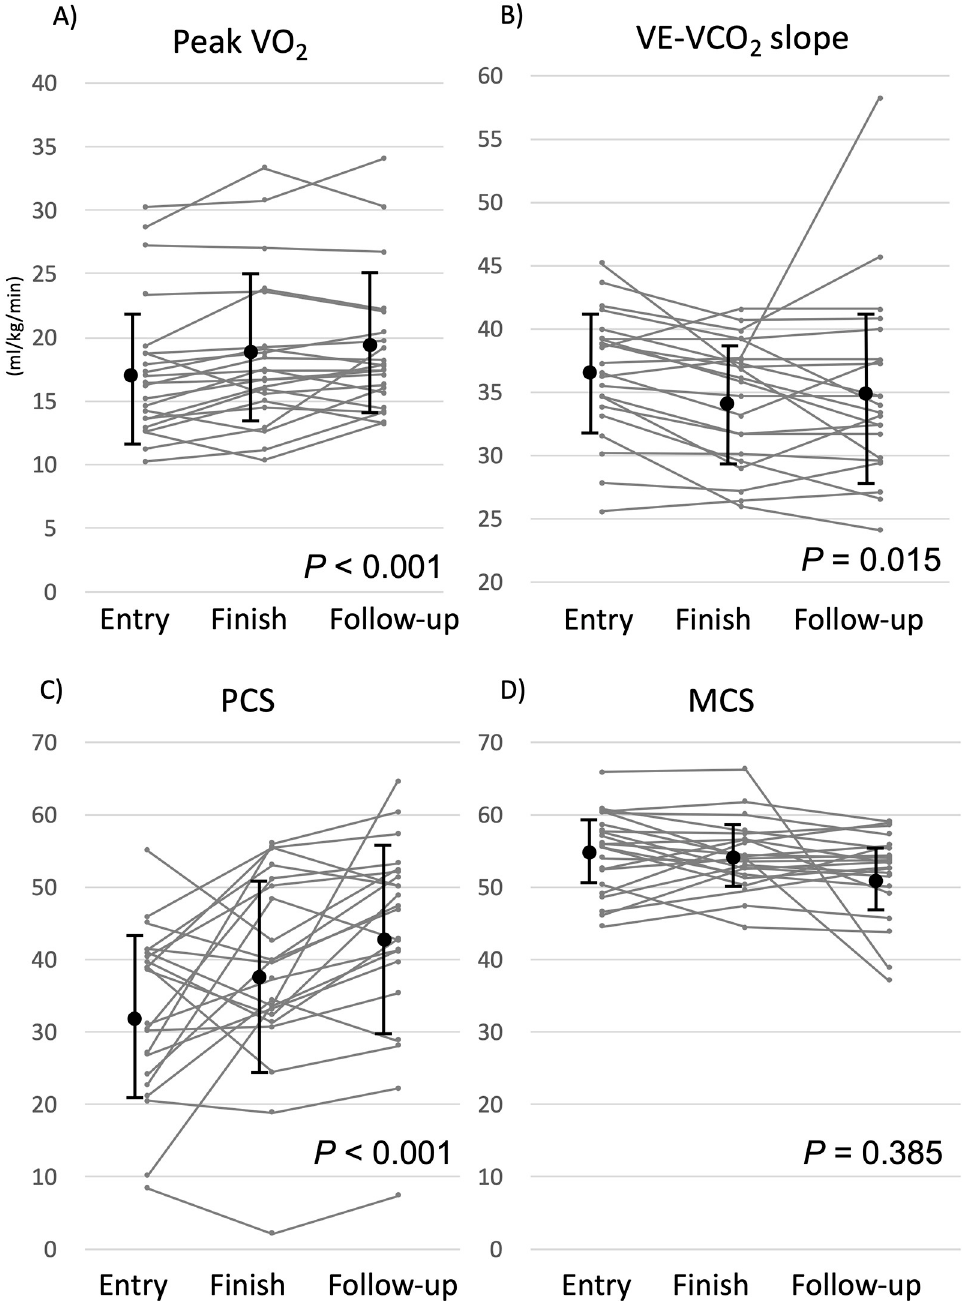
Fig 2. A-D. Trends depicting the peak VO 2 , VE-VCO 2 slope, PCS, and MCS. VO 2 , oxygen intake; VE-VCO 2 slope, ventilation/carbon dioxide slope; PCS, physical component summary; MCS, mental component summary.